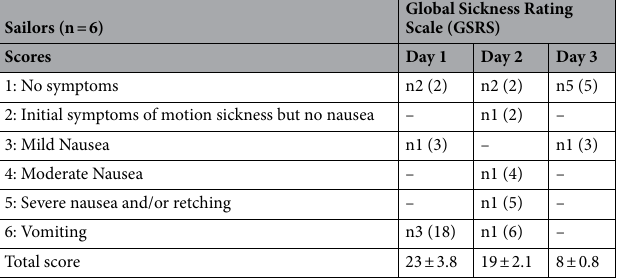
Table 2. Global Sickness Rating Scale (GSRS), number of subjects and (total value) are reported for each day. Total scores ± SD are reported.